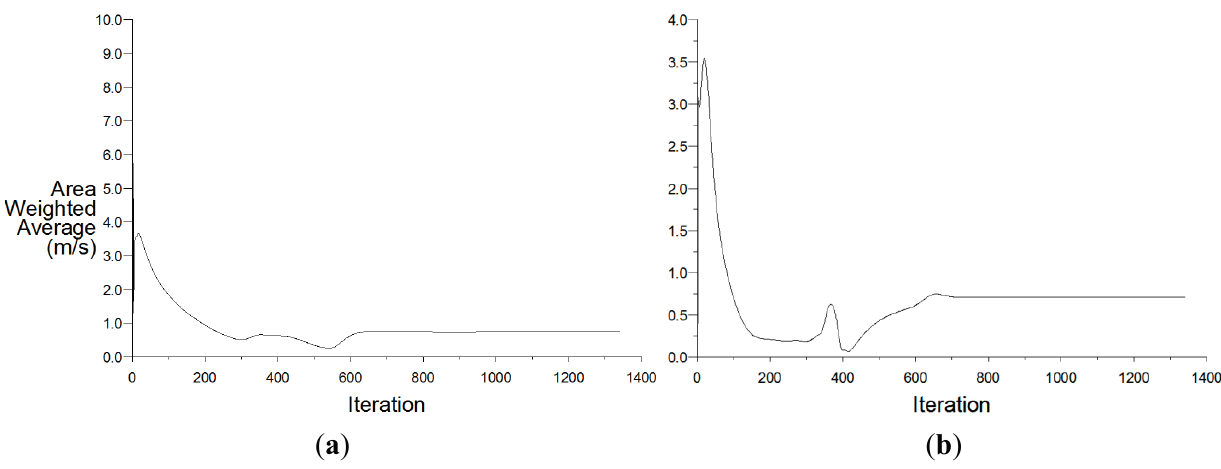
Figure 9. ( a ) Indoor velocity; and ( b ) air supply velocity convergence.